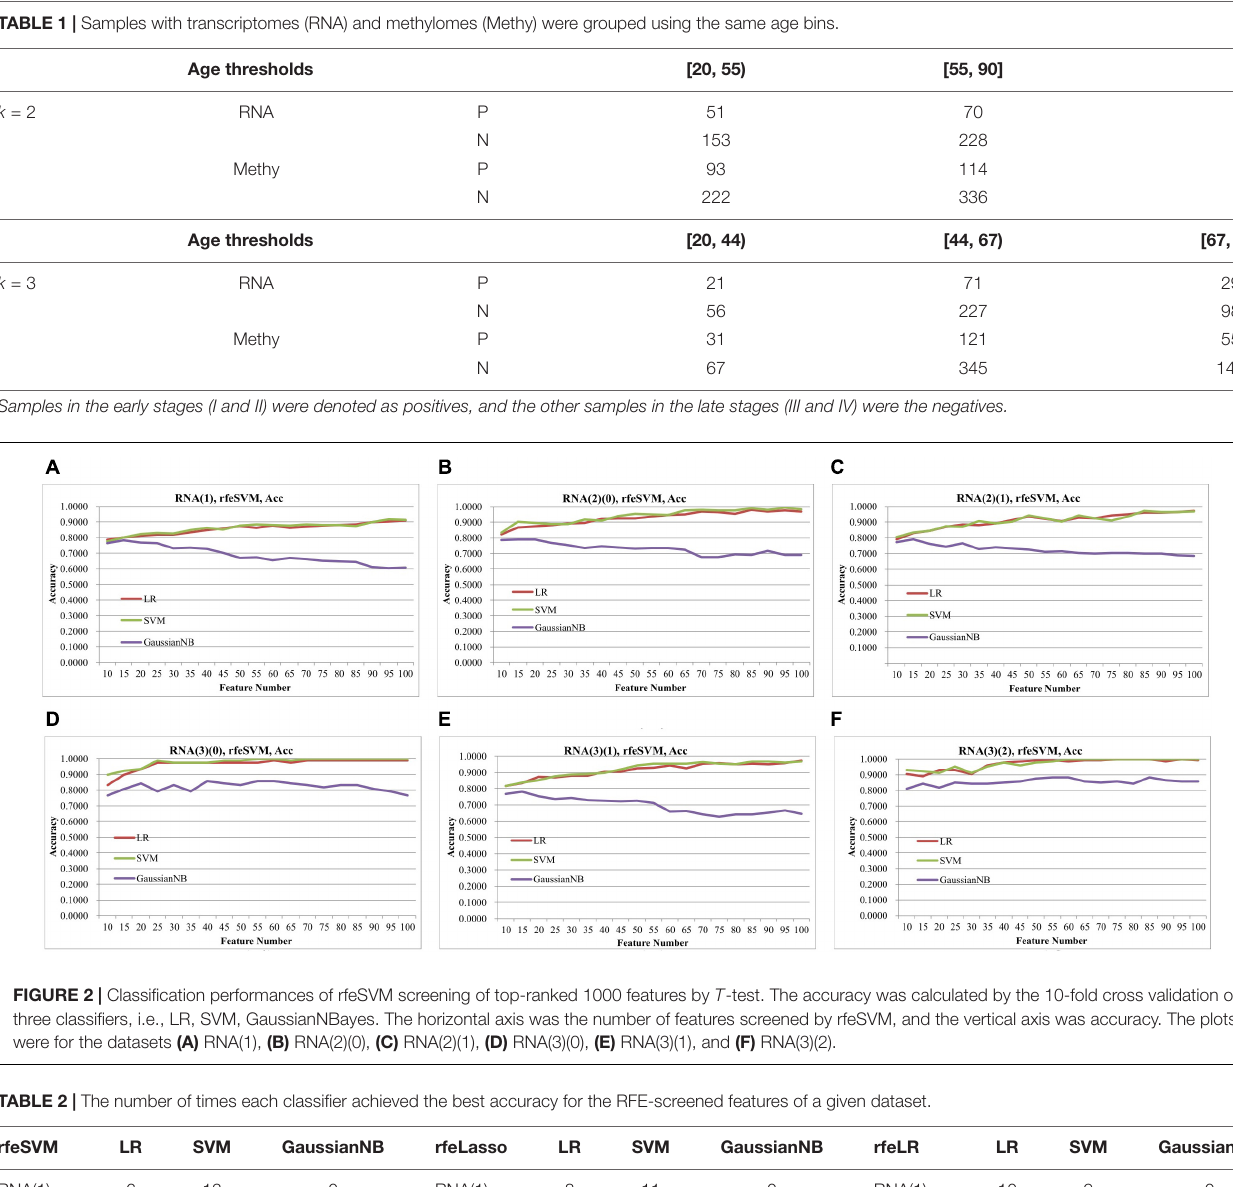
Frontiers in Genetics |